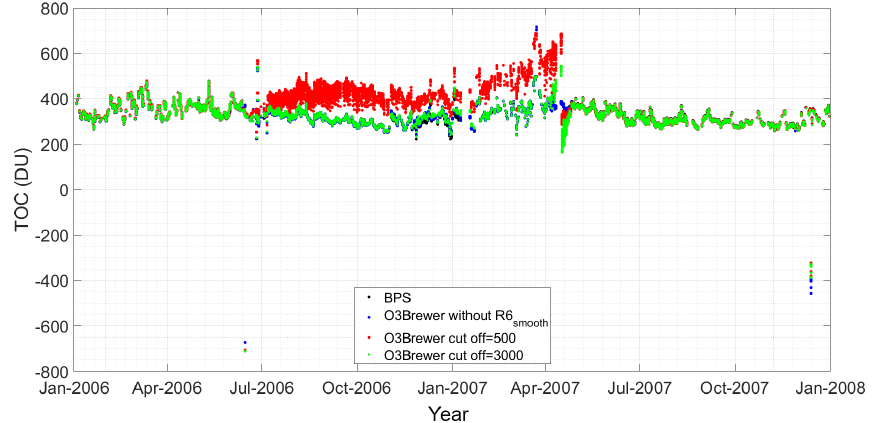
Figure 9. Individual ozone values calculated by the BPS (black), by O3Brewer with the R 6 smooth correction turned off (blue; in this case the daily mean values of the SL test are used for the correction of the ETC), by O3Brewer with the cut-off set to 500 units (red) and by O3Brewer with the cut-off set to 3000 units (green) over the period of the R 6 drift in 2006–2007 at